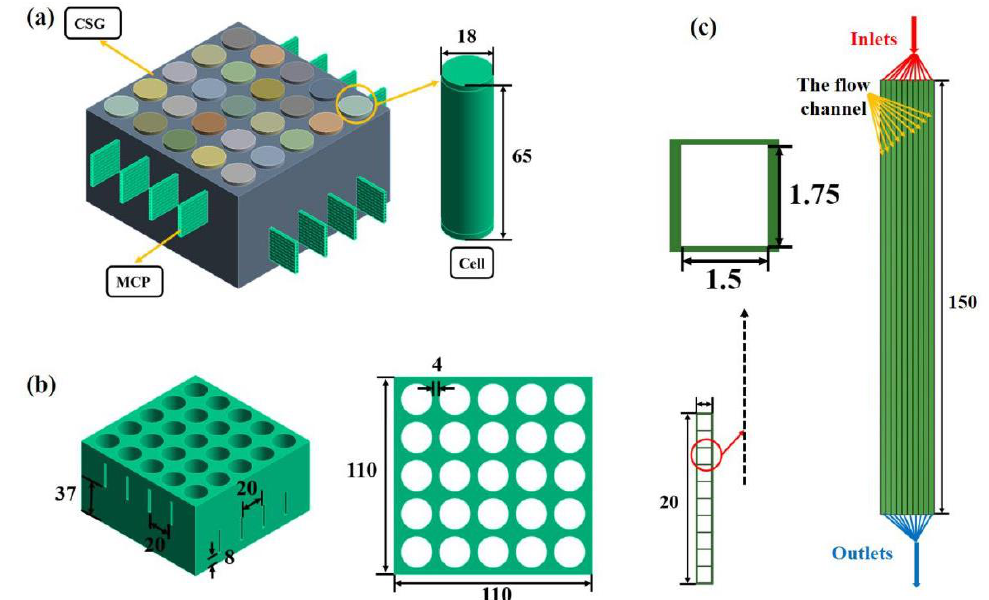
Figure 3. The scheme of the battery model based on CSG and MCP: ( a ) Overview of the battery module and 18,650-type ternary LIB, ( b ) Side view and top view of CSG, ( c ) The section view ( top ) and left view ( bottom ) of the MCP. Table 4. The parameters of the operating conditions in the CSG module.